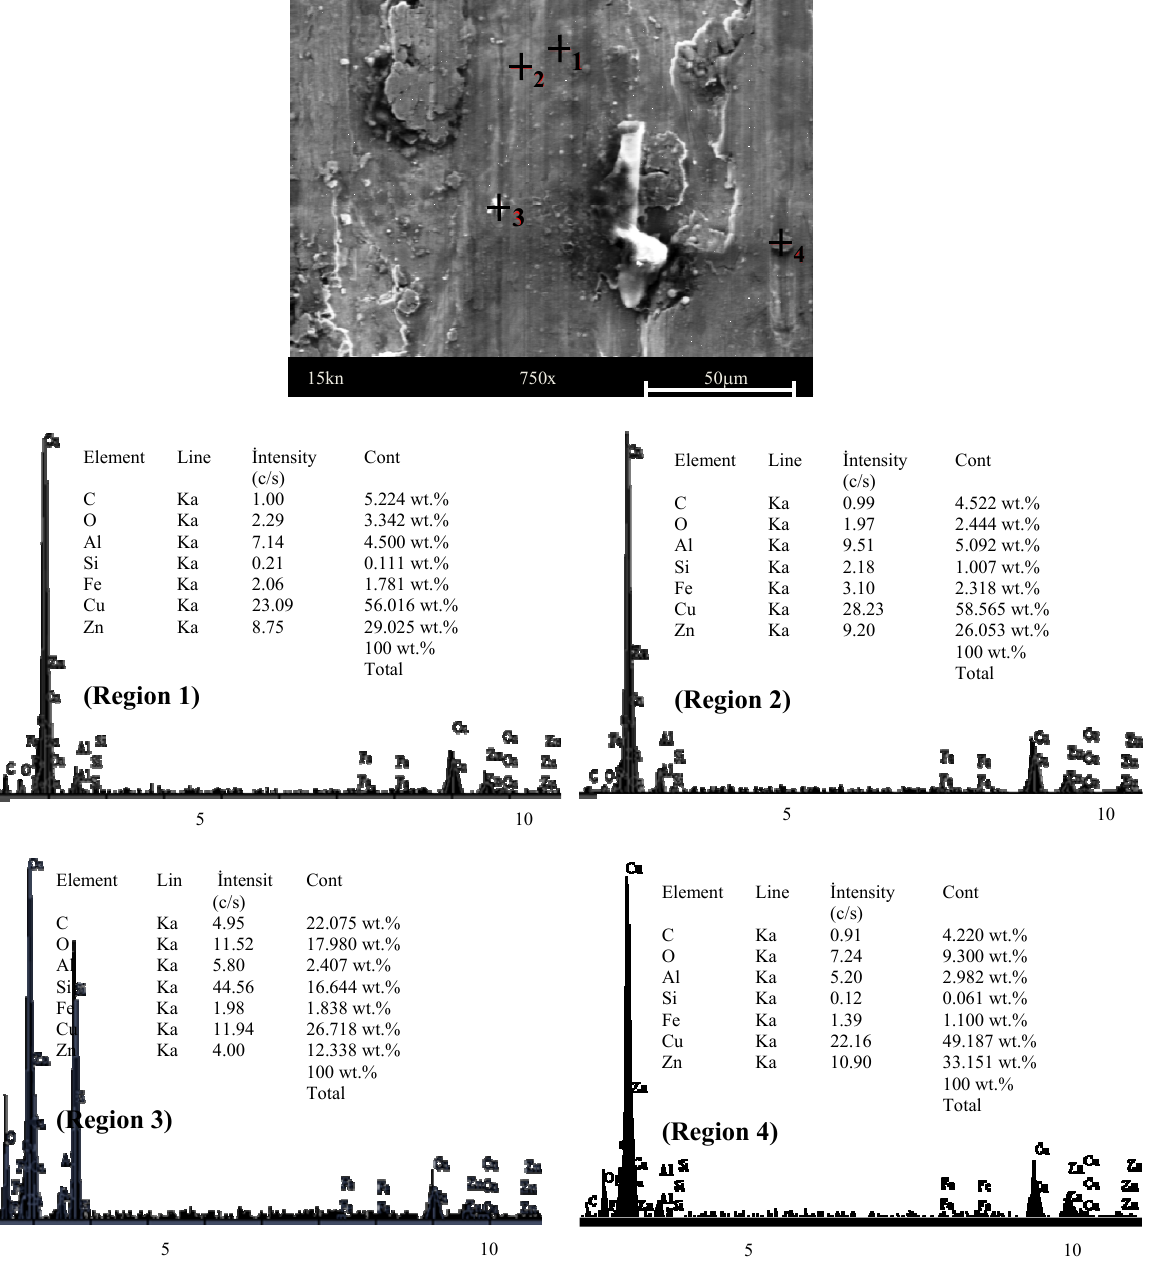
Figure 15. Worn surface SEM and EDAX analysis of centrically cast brass worn under loads of 40 N, at 0.5 m s (cid:3) 1 speed and against pearlitic ductile iron